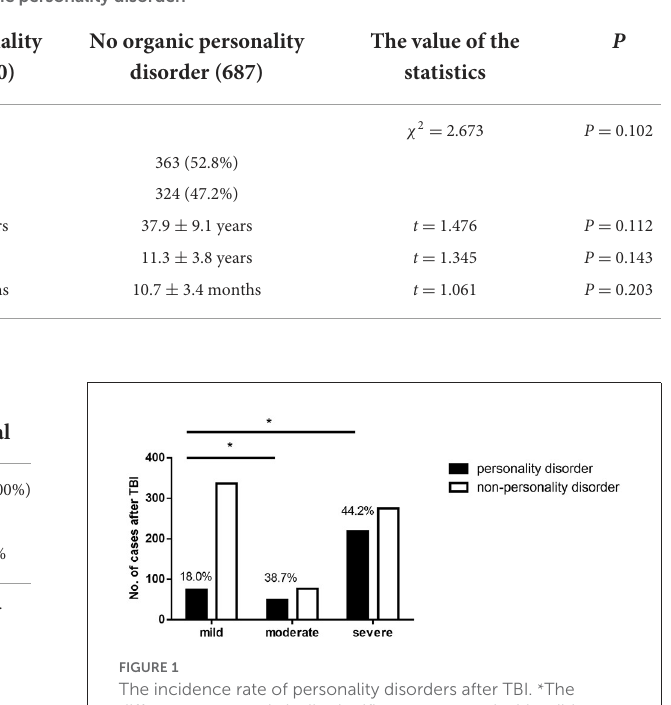
TABLE 1 General demographic characteristics with/without organic personality disorder.